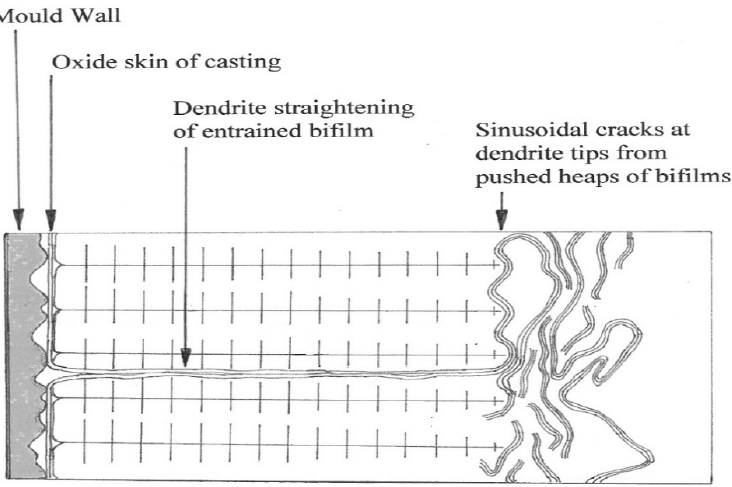
Figure 3. Dendrite ‘pushing’ of bifilms to created transgranular cracks and facets [2]. The preferential precipitation of pores at grain boundaries can now be understood.